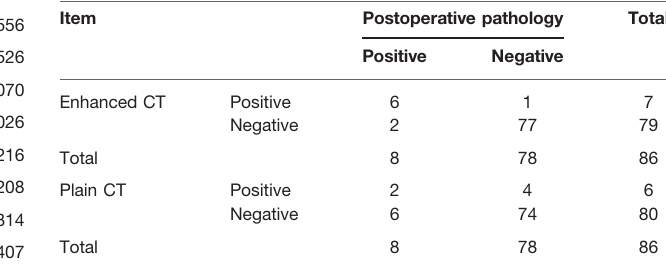
TABLE 5 | Comparison of the results of contrast-enhanced and non-enhanced CT in the diagnosis of nerve invasion in lung adenocarcinoma [ n (%)].